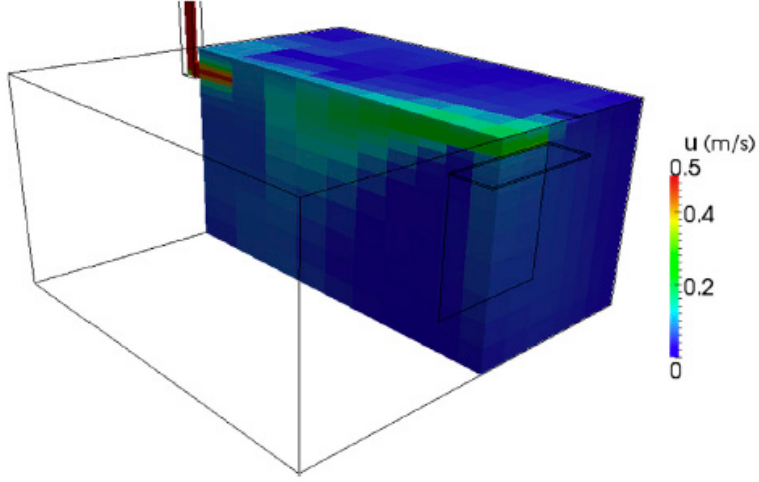
Figure 19. Air velocity distribution found using computational fluid dynamics (CFD) [77].